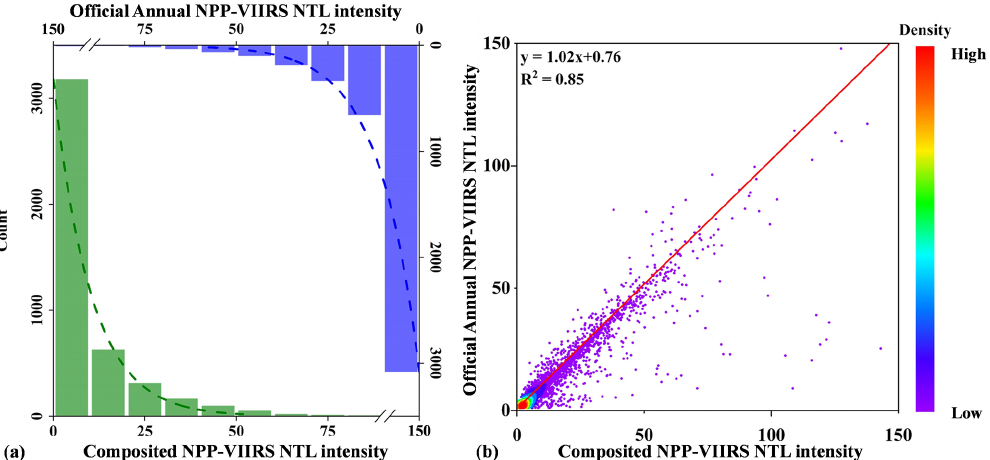
Figure 8. A comparison of composited and official annual NPP-VIIRS NTL data via (a) histograms and (b) scatter plot with kernel density.